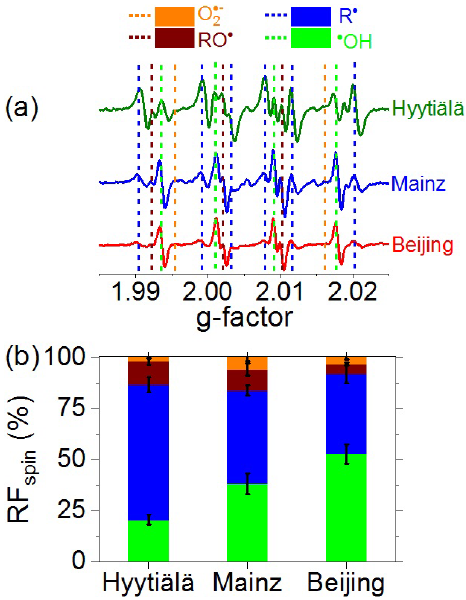
Figure 2. (a) Electron paramagnetic resonance (EPR) spectra and (b) relative fractions of unpaired electrons (RF spin ) attributed to different types of radicals formed in aqueous extracts of ambient PM 2 . 5 from Hyytiälä, Mainz, and Beijing. Dotted vertical lines in (a) indicate the peak positions of different radical adducts. The spectral intensities in (a) and RF spin values in (b) represent arith- metic mean values, while the error bars in (b) represent standard errors (6–13 samples per